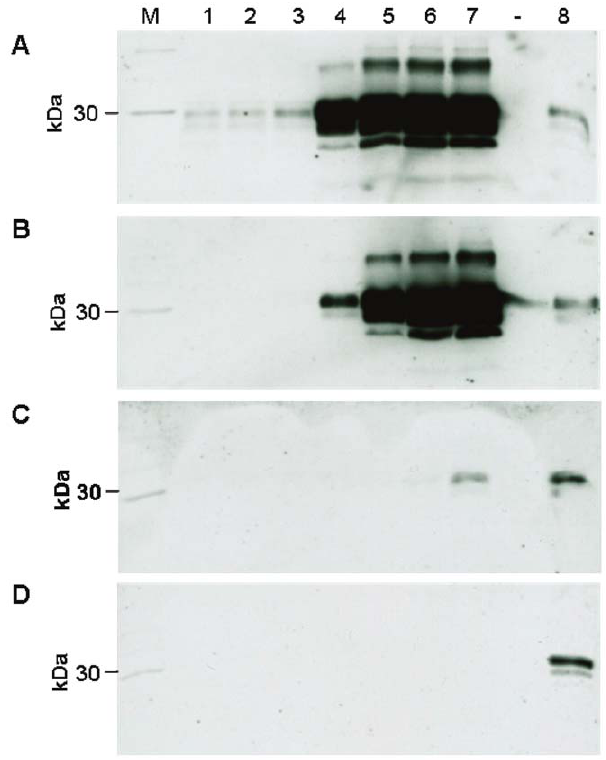
Figure 3. PrP TSE -associated seeding activity in muscles from CWD-infected WTD. Western blot detection of Proteinase K-resistant prion protein (PrPres) after PMCA. For PMCA normal hamster brain homogenate was seeded with 10 m l of a 10% (w/v) CWD brain homogenate from an infected WTD (A), or with PrP TSE -extract from M. semimembranosus/tendinosus of a CWD-infected WTD (Fa-WTD 1, B). In (C) PMCA was seeded with M. semimembranosus/tendinosus from Fa- WTD 2 that had been tested positive for PrP TSE in brain tissue while no PrP TSE could be detected by Western blotting in muscle extracts of this animal (the negative result with this muscle is shown in figure 2, lane 8). (D) Unseeded control in which PMCA was performed with normal hamster brain homogenate only. Lanes 1–7 represent Western blot findings after 1, 2, 3, 4, 5, 6 and 7 rounds of PMCA. Lane 8, Proteinase K- digested brain homogenate from a hamster in the clinical stage of scrapie representing 1 6 10 2 7 g of hamster brain tissue (loaded as an internal blotting control). M: molecular mass marker. Anti-PrP mono- clonal antibody 3F4 was used as primary antibody for the detection of